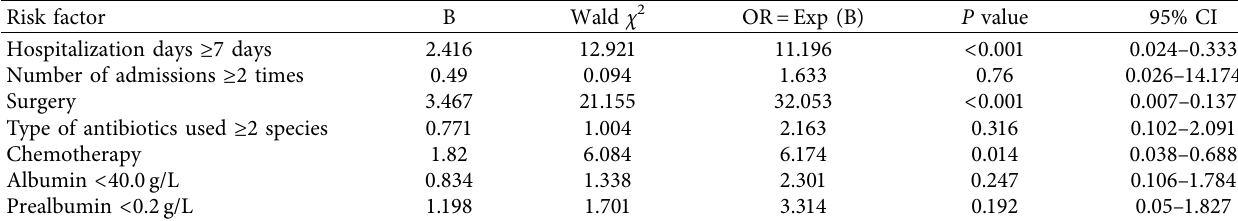
Table 4: Multivariate logistic regression analysis of E. coli BSI in patients with pancreatic cancer. Risk factor